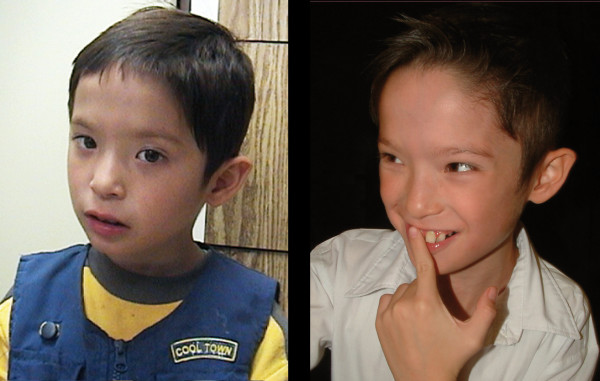
Photographs of patient AU008 with a 15q24 microdeletion. Patient AU008 at (left) 5.1 years and (right) 8.10 years of age. Note the high anterior hairline, long narrow face, broad medial eyebrows, epicanthal folds, hypertelorism, full lower lip, widely spaced teeth and protuberant ears. Specific consent from the parents was obtained to publish these photographs.